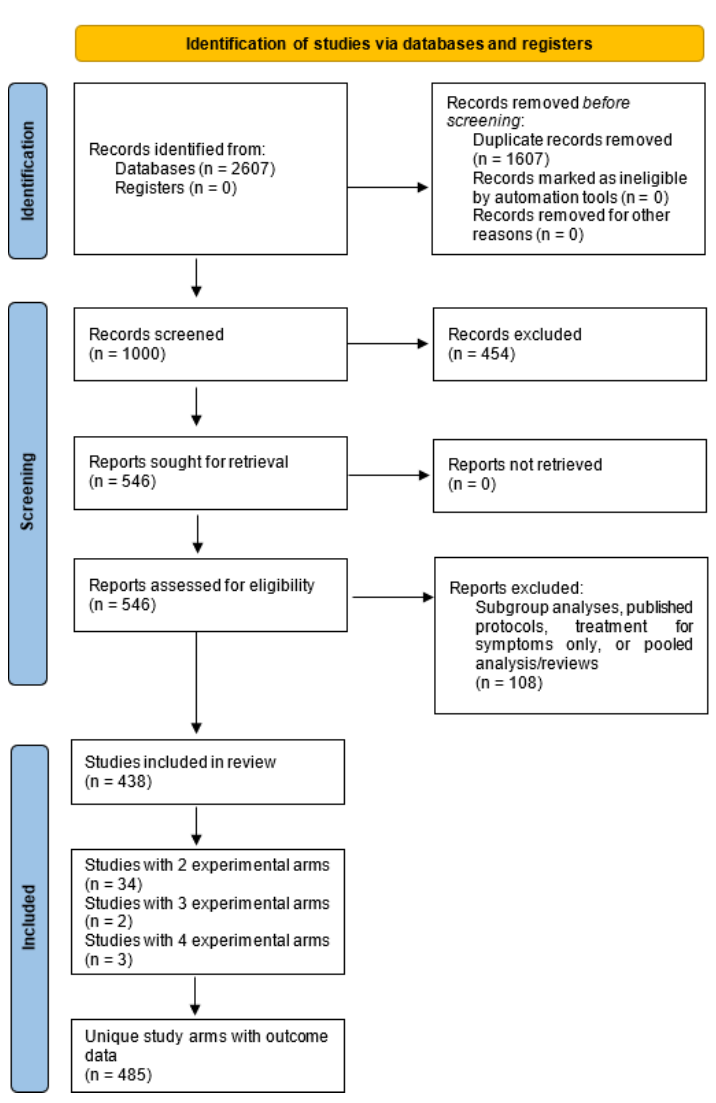
Figure 1. PRISMA 2020 flow diagram for article inclusion [446].